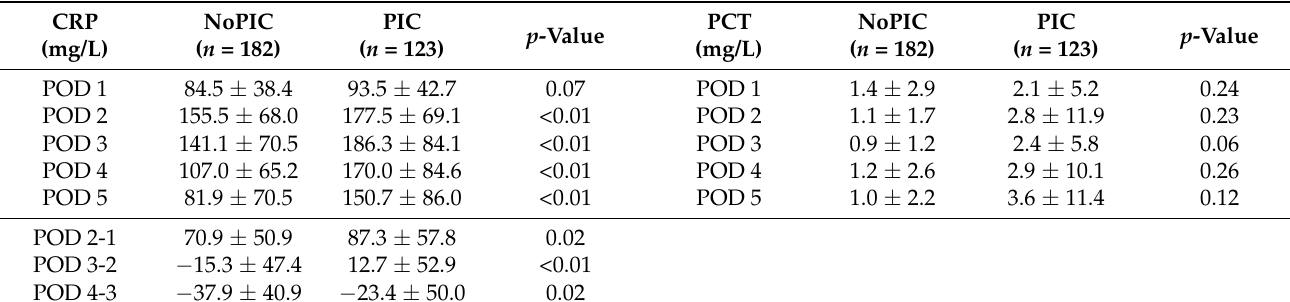
Table 3. Postoperative CRP- and PCT-values of all patients included stratified by the development of PIC (NoPIC vs. PIC). CRP: C-reactive protein, PCT: Procalcitonin, PIC: postoperative infectious complications, POD: postoperative day. Continuous variables were tested using the Students’ t -test (normally distributed). p -values < 0.05 were considered statistically significant and are indicated in